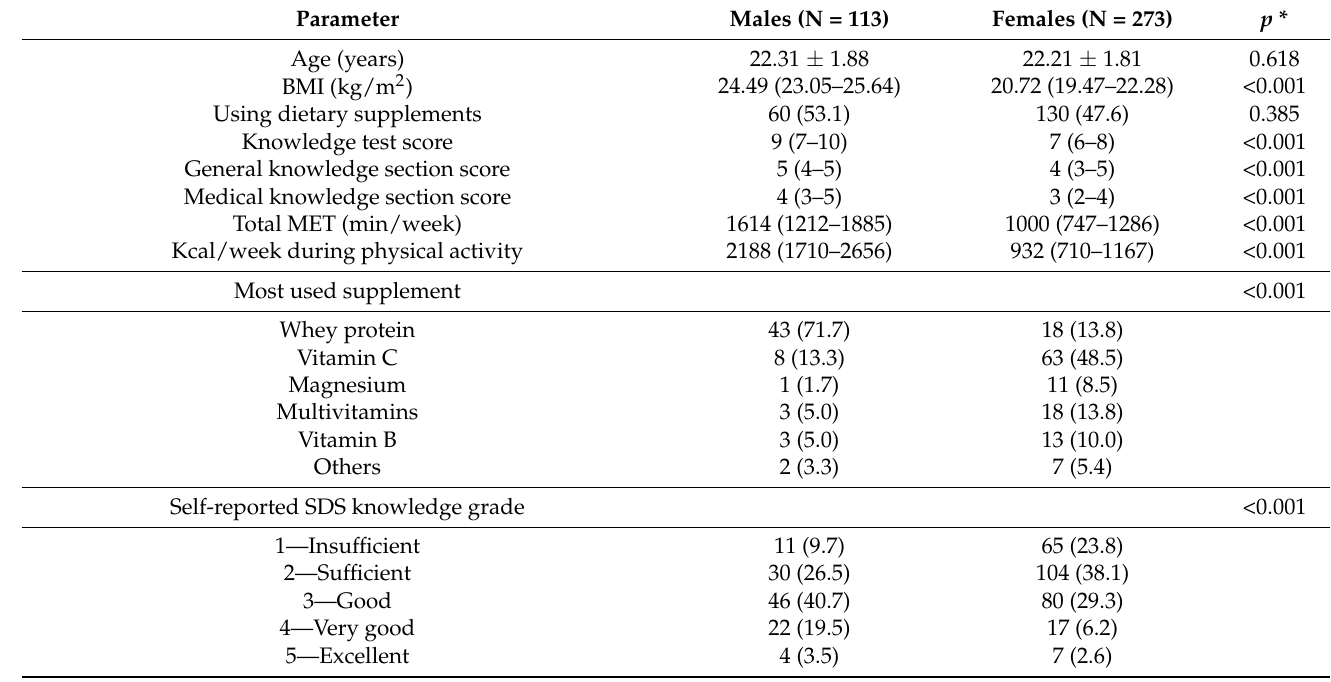
Table 7. Comparison of male and female